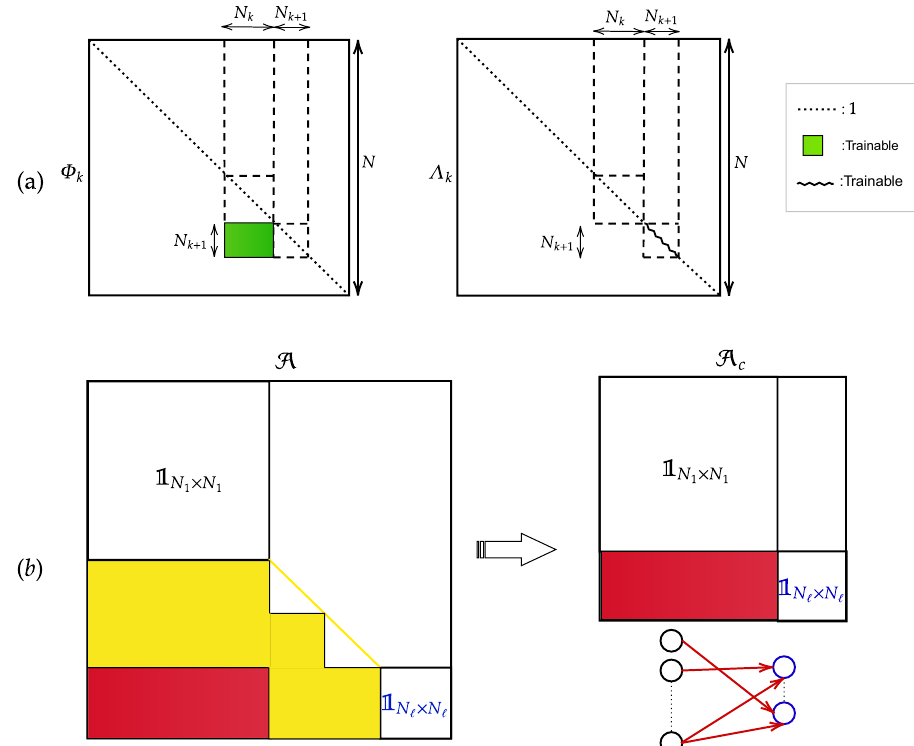
Fig. 2 The choice of the eigenvectors. a The structure of matrix Φ k is schematically depicted. The diagonal entries of Φ k are unities. The sub-diagonal block of size N k + 1 × N k for k = 1, ℓ − 1 is fi lled with uniform random numbers in [ a , b ], with a ; b 2 R . These blocks yield an effective indentation between successive stacks of linearly independent eigenvectors. The diagonal matrix of the eigenvalues Λ k is also represented. The sub-portions of Φ k and Λ k that get modi fi ed by the training performed in spectral domain are highlighted (see legend). In the experiments reported in this paper, the initial eigenvectors entries are uniform random variables distributed in [ − 0.5, 0.5]. The eigenvalues are uniform random numbers distributed in the interval [ − 0.01, 0.01]. Optimising the range to which the initial guesses belong (for both eigenvalues and eigenvectors) is an open problem that we have not tackled. b A ( N 1 + (cid:4) (cid:5) N ℓ ) × ( N + N ℓ ) matrix A A ¼ Π ‘ (cid:2) 1 , which provides the weights for a single-layer perceptron, that maps the input into the c can be obtained from k ¼ 1 A k 1 output, in direct